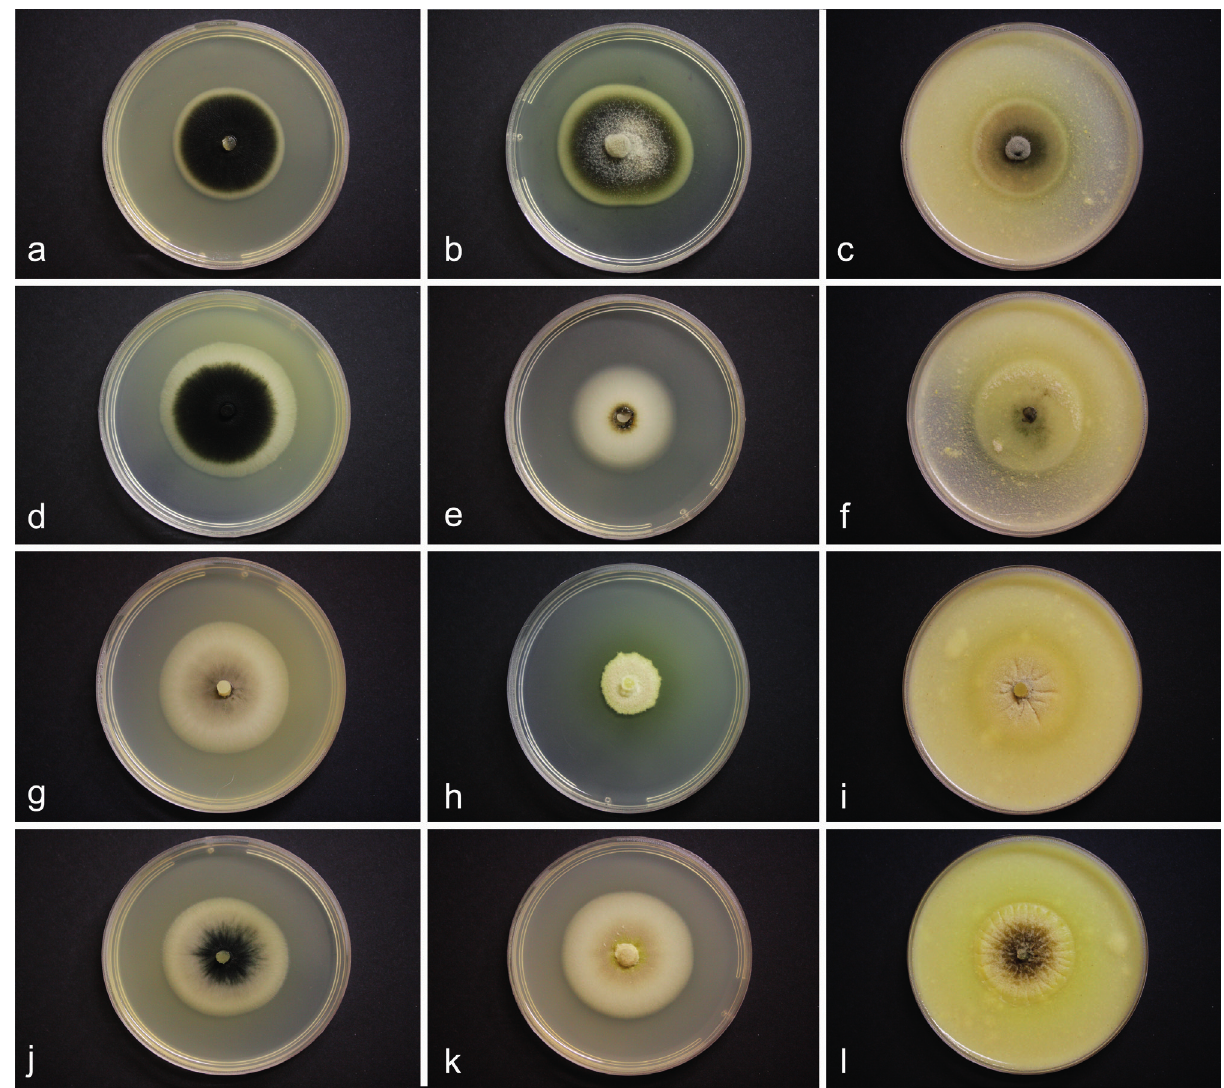
Figure 2. Cadophora luteo-olivacea . Group 1: a–c. Sixteen-day-old colonies on MEA (a), PDA (b) and OA (c). Group 2: d-f, Sixteen-day-old colonies on MEA (d), PDA (e) and OA (f). Group 3: g-i. Sixteen-day-old colonies on MEA (g), PDA (h) and OA (i). Group 4: j-l. Sixteen-day-old colonies on MEA (j), PDA (k) and OA